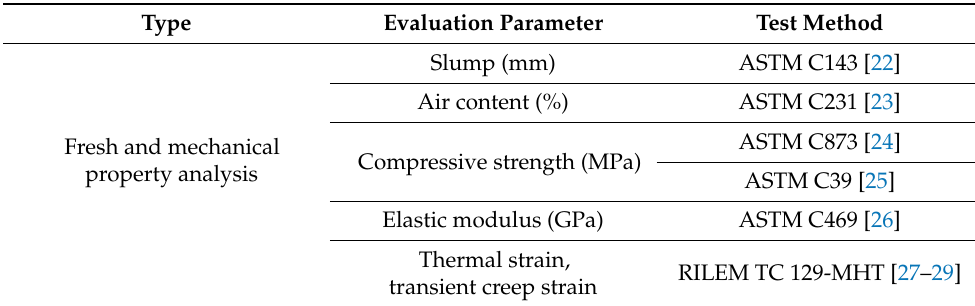
Table 5. Test methods for estimating fresh and hardened properties of